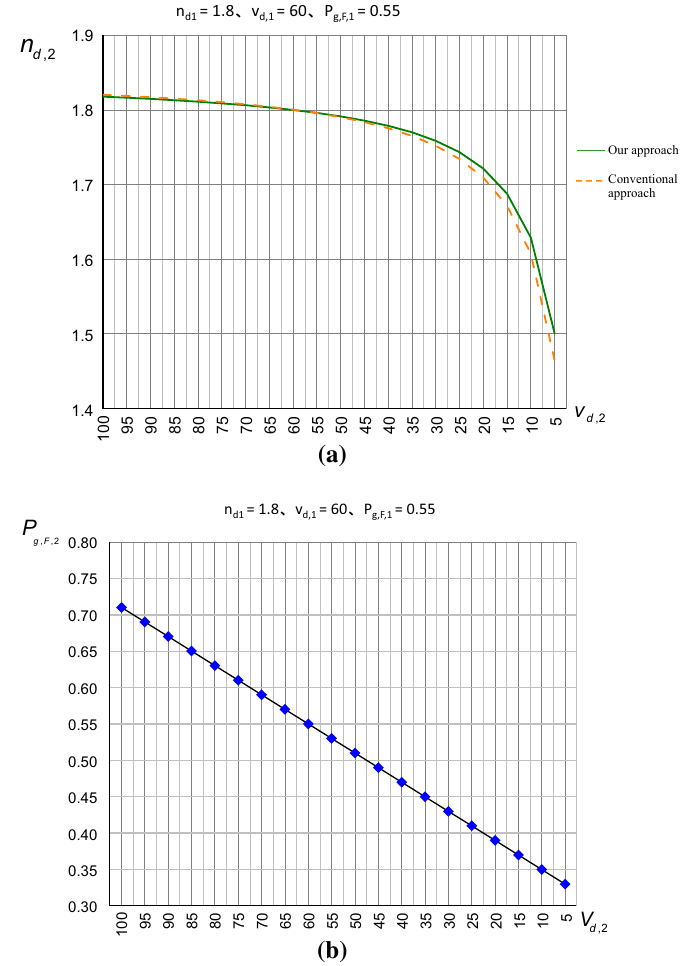
Figure 5. Abbe and partial dispersion characteristic curves. ( a ) our result of Abbe characteristic curve in comparison with the conventional one ( b ) our result of partial dispersion characteristic